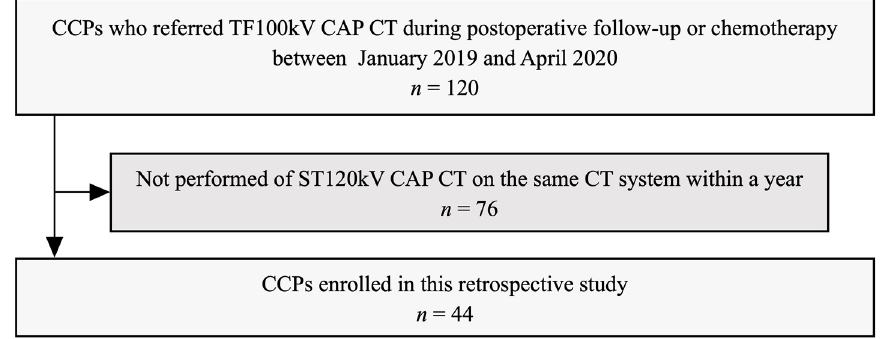
Figure 1. Recruitment pathway for patients in the present study CCPs, colorectal cancer patients; TF100kV, tin-filtered 100 kV; CAP, chest–abdominal–pelvic; ST120kV, standard 120 kV.